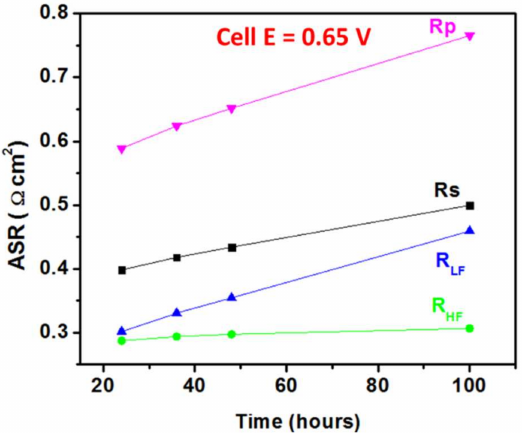
Figure 5. Total polarization (Rp), ohmic (Rs), high frequency (RHF), and low frequency (RLF) resistance trends of a symmetrical LCFCr/GDC/LCFCr cell as a function of time in air at 800 ◦